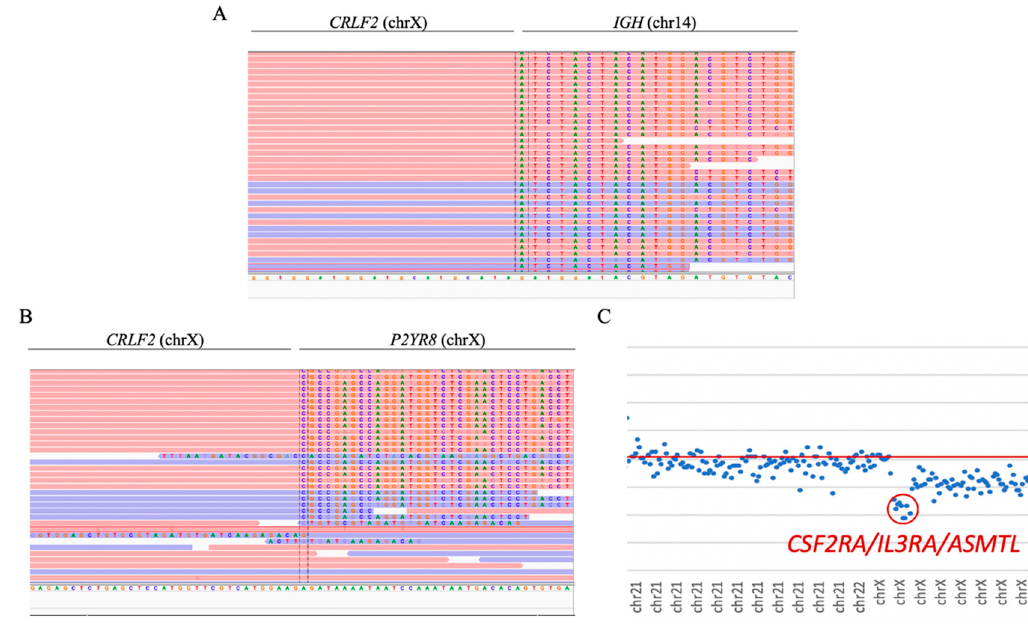
Figure 4. Fusion genes visualized with integrative genomics viewer (IGV). ( A ) ETV6/RUNX1 fusion gene (sample ID52). In the left region, the reads were aligned with intron 5 of ETV6 , while in the right, the reads were aligned with intron 3 of RUNX1 . ( B ) BCR/ABL1 fusion gene (sample ID63). In the left region, reads were aligned with intron 1 of BCR ; to the right, reads were aligned with intron 1 of ABL1 . ( C ) MLL/ENL fusion gene (sample ID30) and MLL/AF4 fusion (sample ID27). In the left region, reads were aligned with intron 10 of MLL ; to the right, reads were aligned with the intergenic region next to ENL and intron 3 of AF4 , respectively. The position of the breakpoint was determined by MANTA software.